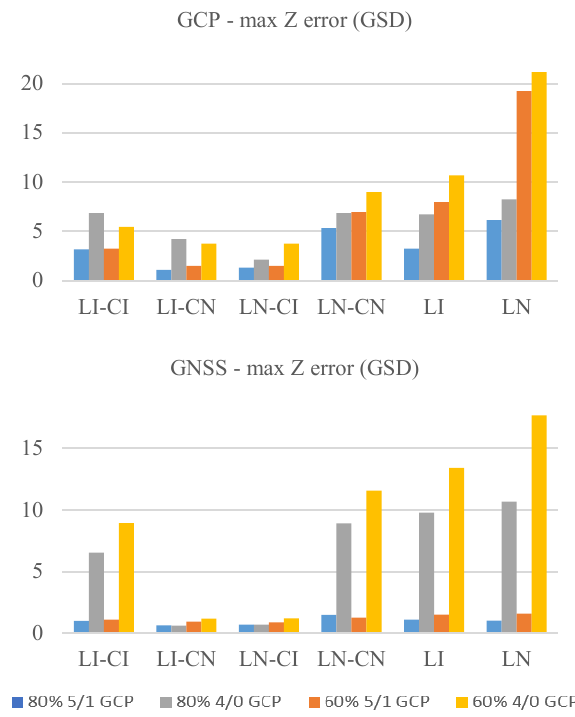
Figure 6 . Maximum Z error in GSD units for the six basic configurations in the GCP (top) and GNSS (bottom)